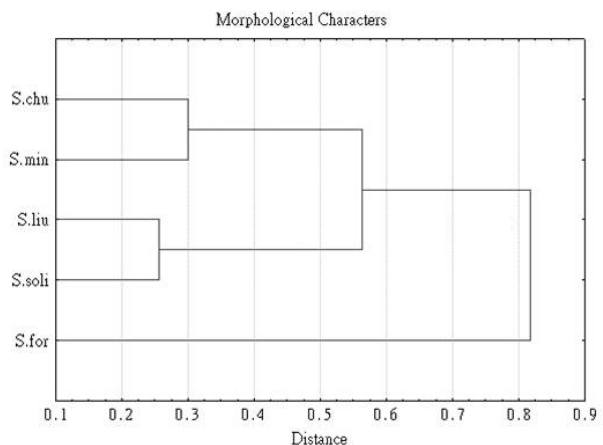
Fig 3. Cluster analy s is based on the morphological characters. (Sin - gle link, 1-Pearson r). (S.for: S. formosensis ; S.min: S. minutula ; S.chu: S. chuchihensis ; S.liu: S. liukueiensis ; S.soli: S. solifontis